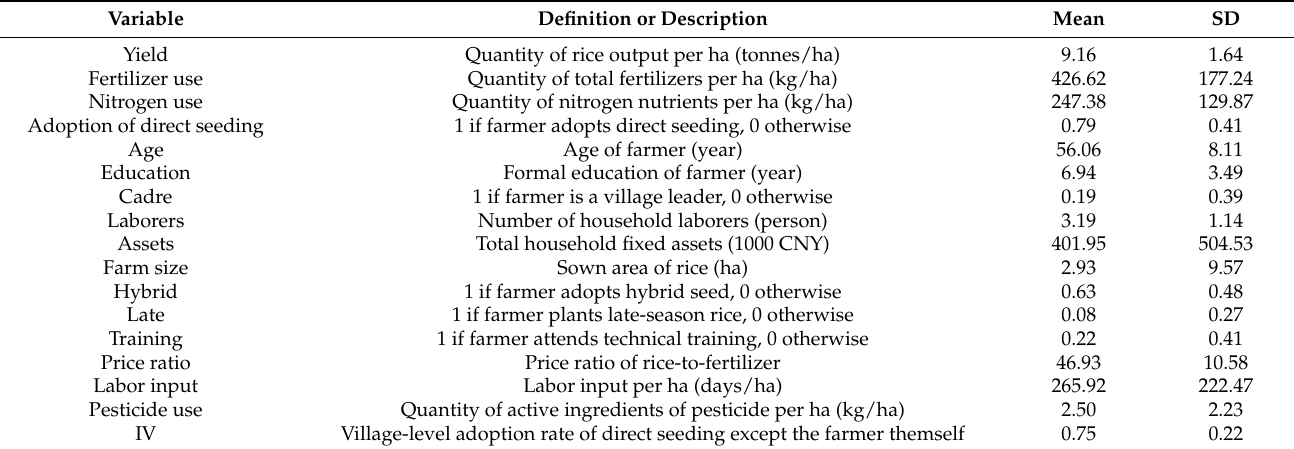
Table 1. Definition and descriptive statistics of variables.